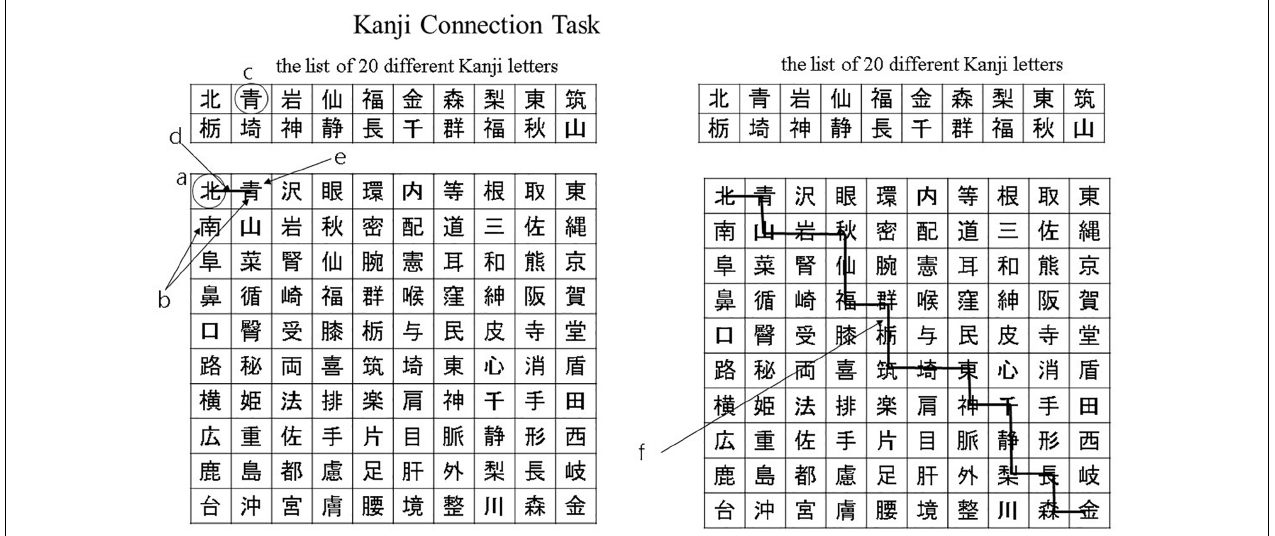
FIGURE 1 | Kanji connection task. (a) The participants began from the first Kanji letter in the upper-left corner of the 10 × 10 grid. (b) The participants were instructed to look at the Kanji letters on the right and toward the bottom of the first Kanji letter. (c) The participants were instructed to match it with a Kanji letter included in the list of 20 different Kanji letters in the table. (d) When one of them would match, they connected this Kanji letter to the first Kanji by drawing a line from one to another. (e) The new Kanji letter would take the place of the first Kanji letter. (f) The participants were asked to repeat this process for all the Kanji letters until they reached the Kanji letter in the bottom-right corner of the